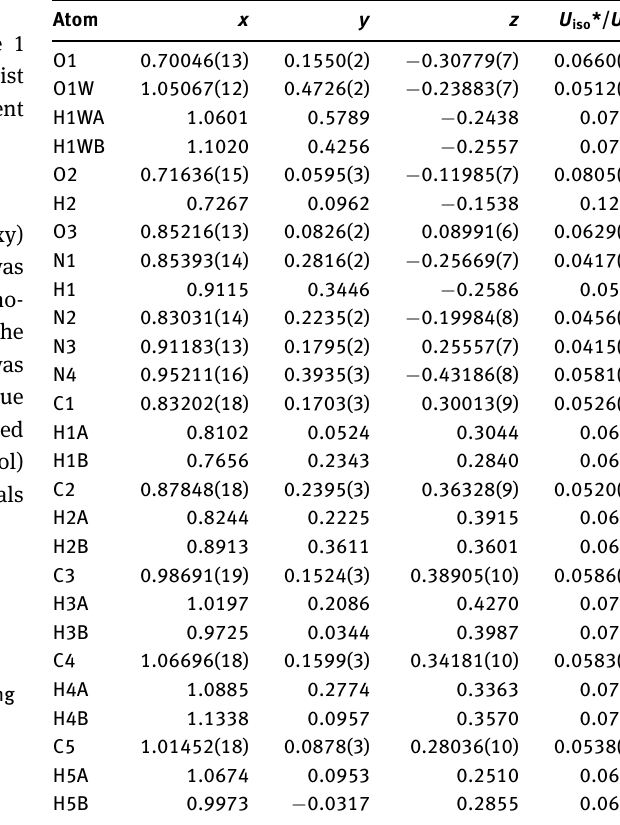
Table 2: Fractional atomic coordinates and isotropic or